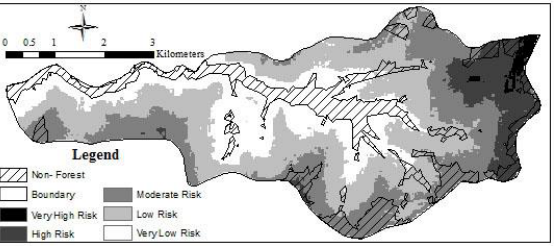
Figure 4. Deforestation risk zoning using analytical hierarchy process